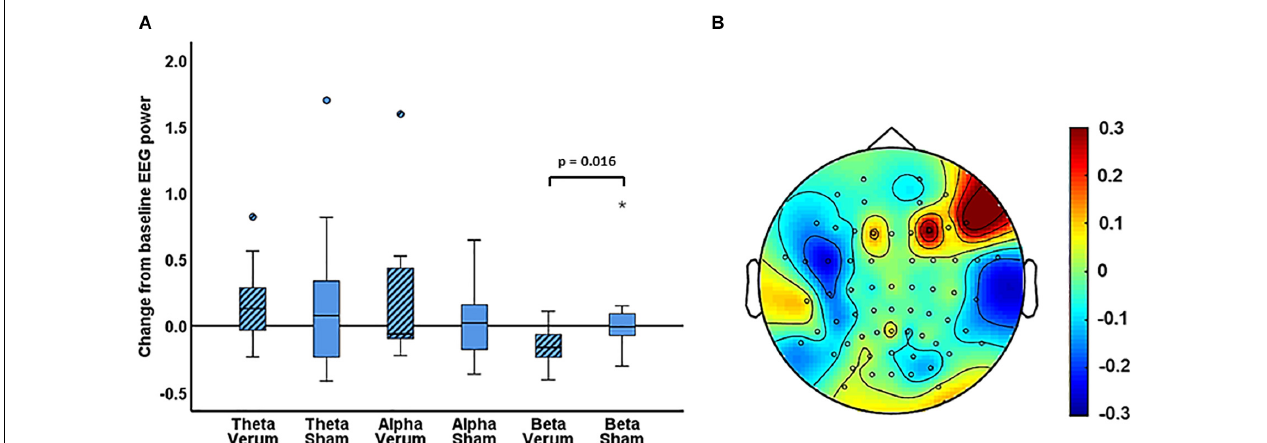
FIGURE 3 | (A) Boxplots of the change from baseline scores ((EEG power post – EEG power pre)/EEG power pre) for the verum and sham PEMS condition, and for the theta, alpha, and beta band, separately. The ◦ and the * in the figure indicate outliers. (B) A topography plot of the average change from baseline of beta power for the PEMS condition (verum stimulation).